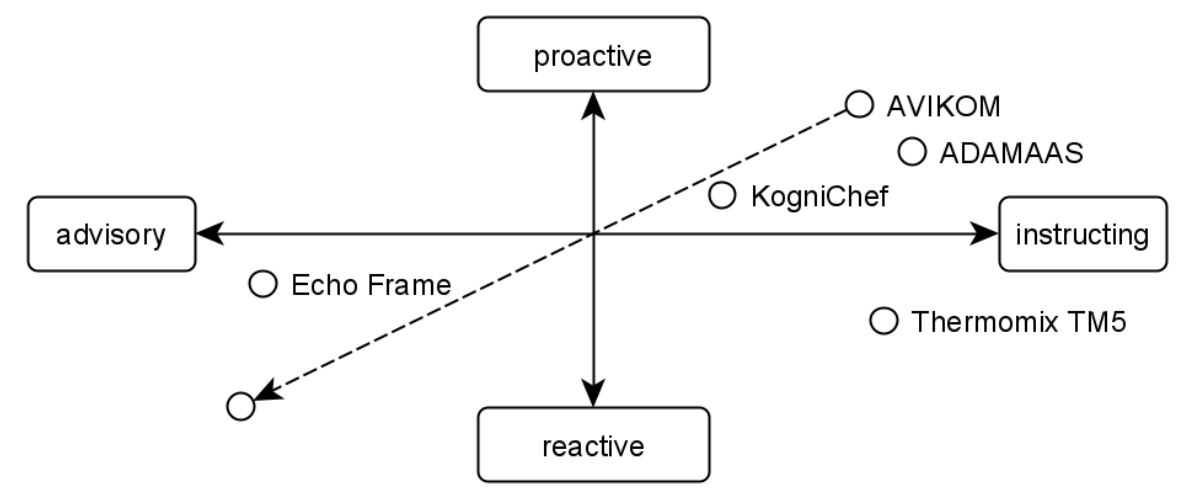
Figure 1. Assistance systems may act as advisors, instructors, or a combination of both. Systems may also require a varying amount of user feedback to assess the task’s context. The currently developed AVIKOM system initially assists users with proactive instructions and subtly withdraws into a reactive advisory role over